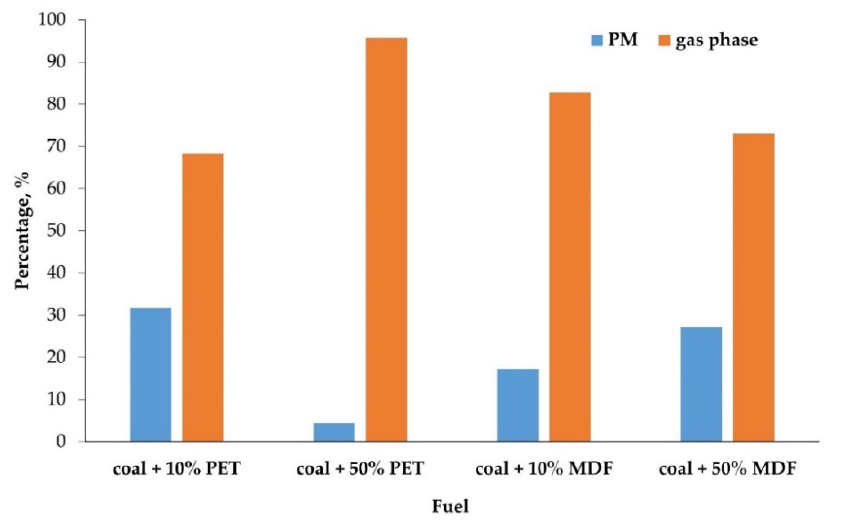
Figure 4. Percentage distribution of alkylphenols across the studied phases.